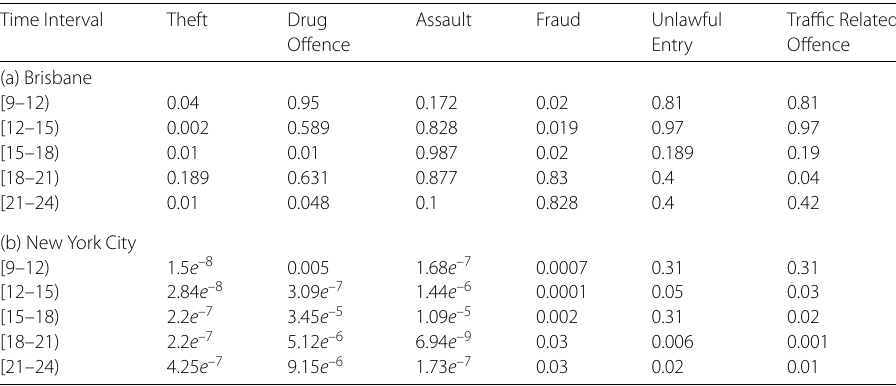
Table 8 Estimated p -value for different crime types at different time interval Time Interval Theft Drug Assault Fraud Unlawful Offence